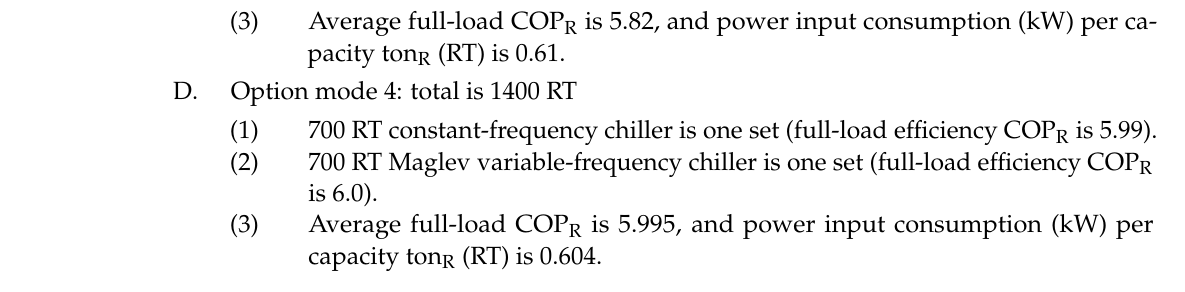
Table 10. Case study analysis 2.